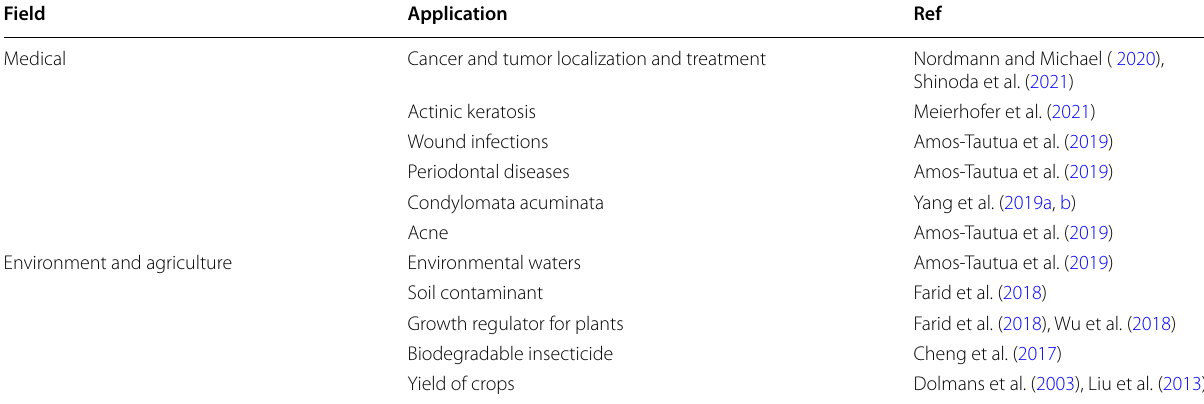
Table 6 Application of ALA in various fields